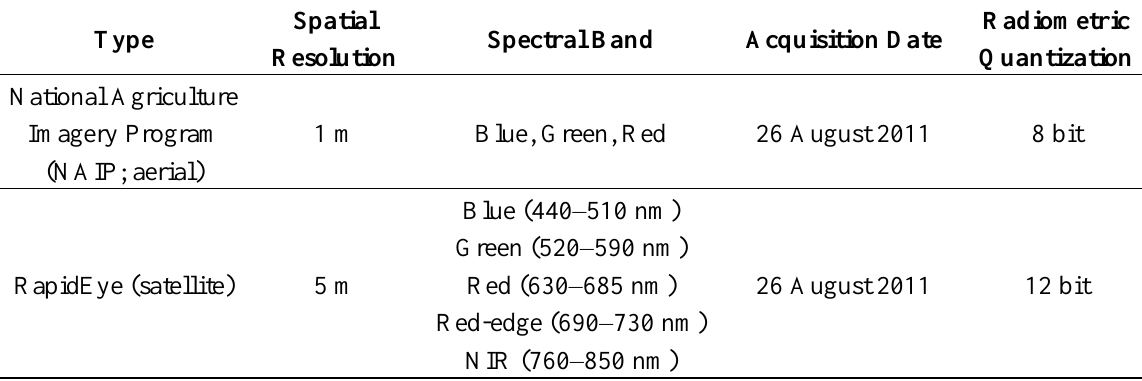
Table 1. Specification of Remotely Sensed